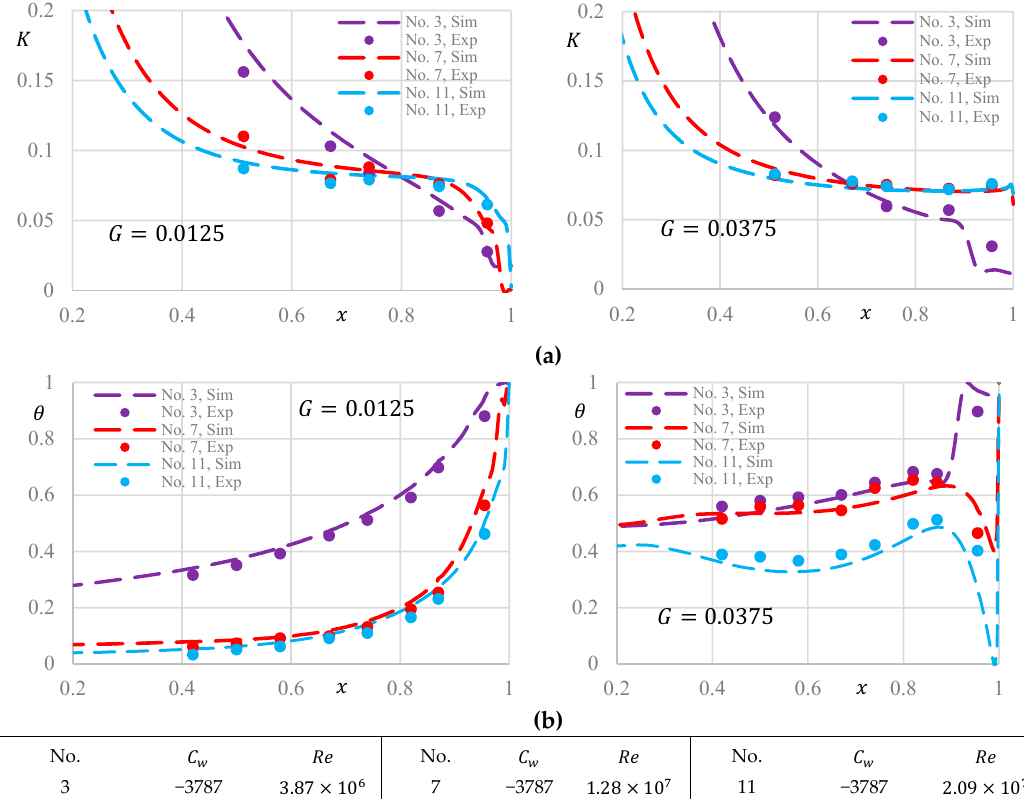
Figure 4. Verification of the numerical simulation set-ups: ( a ) distribution of 𝐾 and ( b ) distribution of 𝜃. Sim: from numerical simulations; Exp: by measurements.